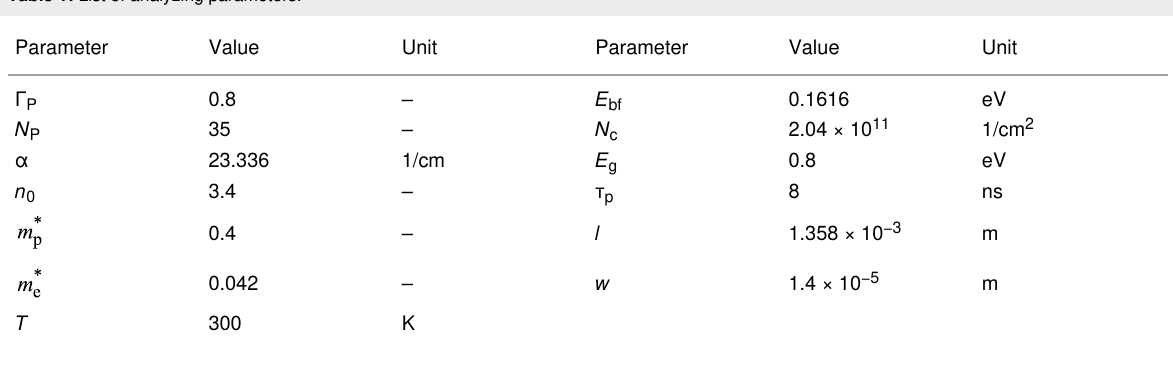
Table 1: List of analyzing